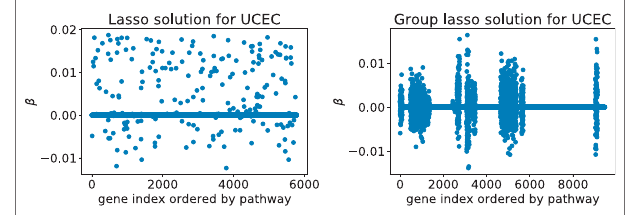
FIGURE1| TypicalsolutionsminimizingtheCoxlossfunctionwitheither the lasso (left) or the group lasso regression term (right) , here computed for the UCEC gene expression data: these two models predict survival of cancer patientsbasedonexpressionvaluesforgenesfromdownstreamtargets of 69 signaling pathways. The number of inputs varies between the two examplessincetheimplementationoflatentgrouplassoduplicatesgenesthat appear in more than one group ( i.e. , set of signaling pathway downstream